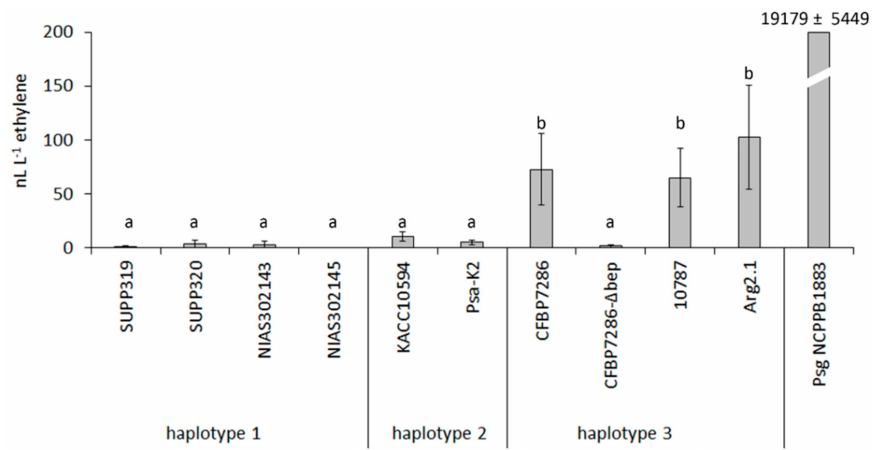
Figure 1. Ethylene emissions from bacterial cultures of several Pseudomonas syringae pv. actinidiae strains. Measures were taken 3 days after inoculation of fresh plant extract. Negative control (axenic medium) was taken for reference, and its reading was subtracted to all the values. Strain CFBP7286- ∆ bep is a defective mutant for the gene Bacterial Ethylene Putative Producer ( bep ). Different letters indicate statistically different ethylene contents ( p ≤ 0.05, n = 3) according to ANOVA and Fisher’s least significant difference test. A strain of P. syringae pv. glycinea (Psg NCPPB1883), used as the positive control, was not considered for statistics.